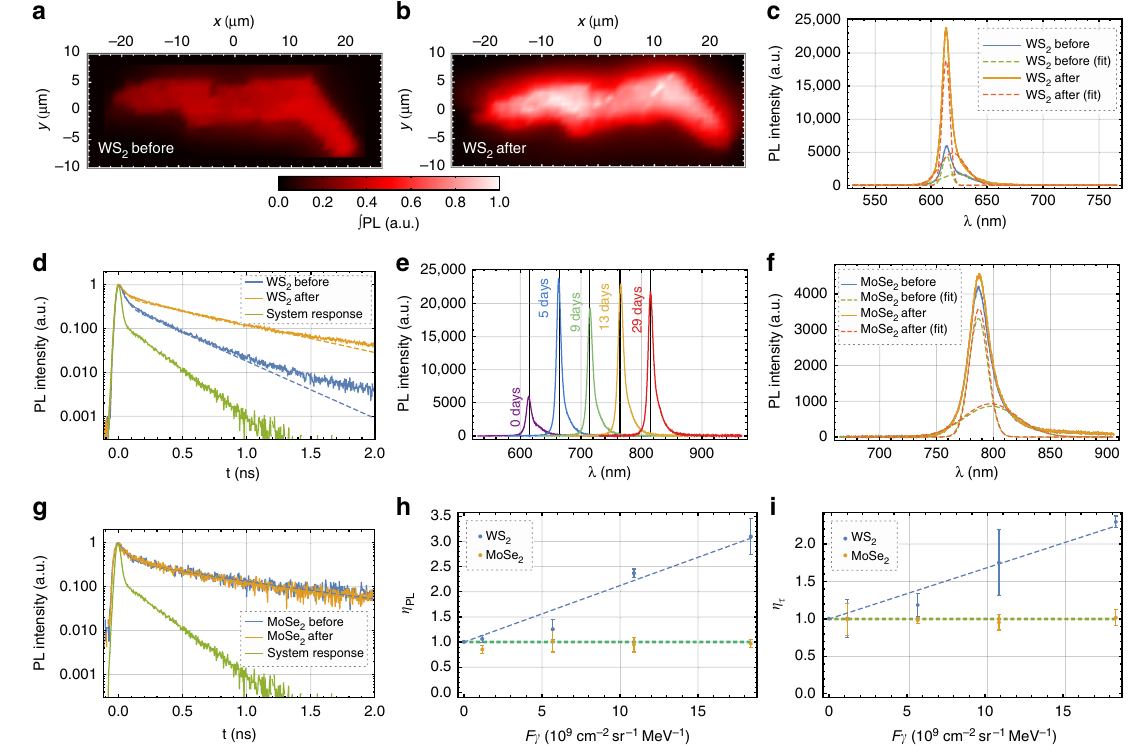
Fig. 4 γ -Ray tests of transition metal dichalcogenide monolayers. a – e Optical characterization of a WS 2 monolayer before and after the γ -ray exposure. a , b The photoluminescence (PL) intensity maps scanned with 1 μ m resolution integrated over the full spectrum show a strong increase in brightness after the irradiation. c In addition to the brightness increase of 2.99, the PL spectrum shows that the exciton/trion ratio also changed from 0.706(11) to 1.138 (19). This was extracted from fi tting two Gaussian distributions. d Similarly, the radiative carrier lifetime increased from 336(3) to 678(5) ps. The fi t routine deconvolutes the data from the system response. e Long-term stability of the PL spectrum measured at different days. The irradiation took place at day 2. For clarity, each subsequent spectra is shifted by 50 nm. The peak wavelength remained invariant with its mean at 614.65 nm. The mean peak wavelength is visualized with the black guidelines. f , g PL emission spectrum and carrier lifetime for monolayer MoSe 2 . This material remains predominantly unaffected by the gamma-rays, with the overall brightness increased by <5% and the radiative lifetimes before and after the irradiation being 1086(41) and 1071(47) ps, respectively. Both sample monolayers experienced the same photon fl uence. h , i Relative brightness and carrier lifetime increase as a function of γ -ray fl uence averaged over all samples for WS 2 and MoSe 2 . While there is little to no change for MoSe 2 , for WS 2 the relative changes are linearly proportional to the radiation fl uence. The data point at zero is the control sample. The green dashed line indicates η = 1 (no change). The error bars are the standard deviation of the